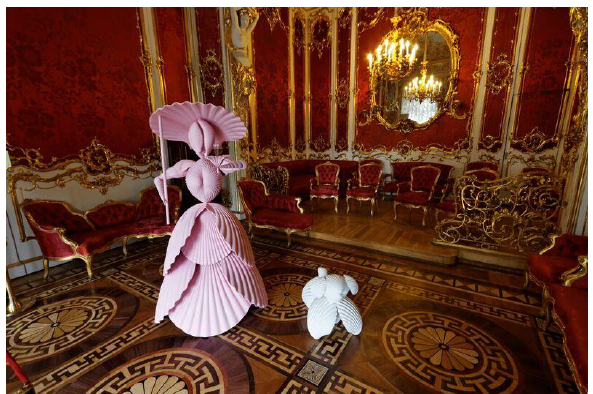
Figure 2 | Katharina Fritsch, Woman with Dog (2004). With the support of the Arts Foundation of North Rhine-Westphalia and the